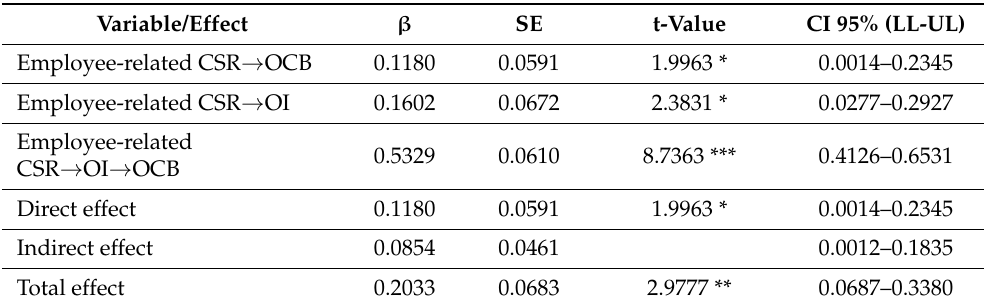
Table 5. Regression Coefficients, Standard Errors, and Model Summary Information (Mediation Model_Employee-related CSR).